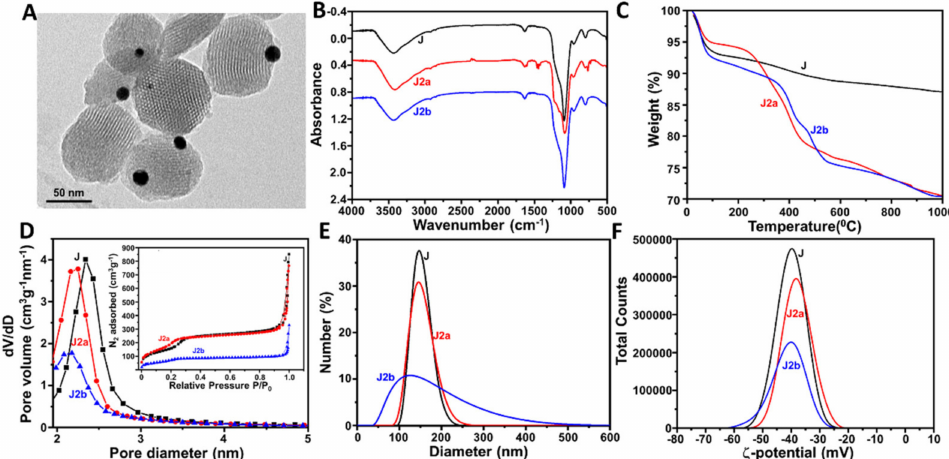
Figure 2. Characterization of the J2c nanodevice: ( A ) HR-TEM image of J. ( B ) infrared spectra and ( C ) thermograms for the Janus Au-MS nanoparticles J, J2a, and J2b. ( D ) N 2 adsorption-desorption isotherms for J, J2a, and J2b (Inset: pore size distribution). ( E ) Hydrodynamic diameter and ( F ) Zeta potential of J, J2a, and